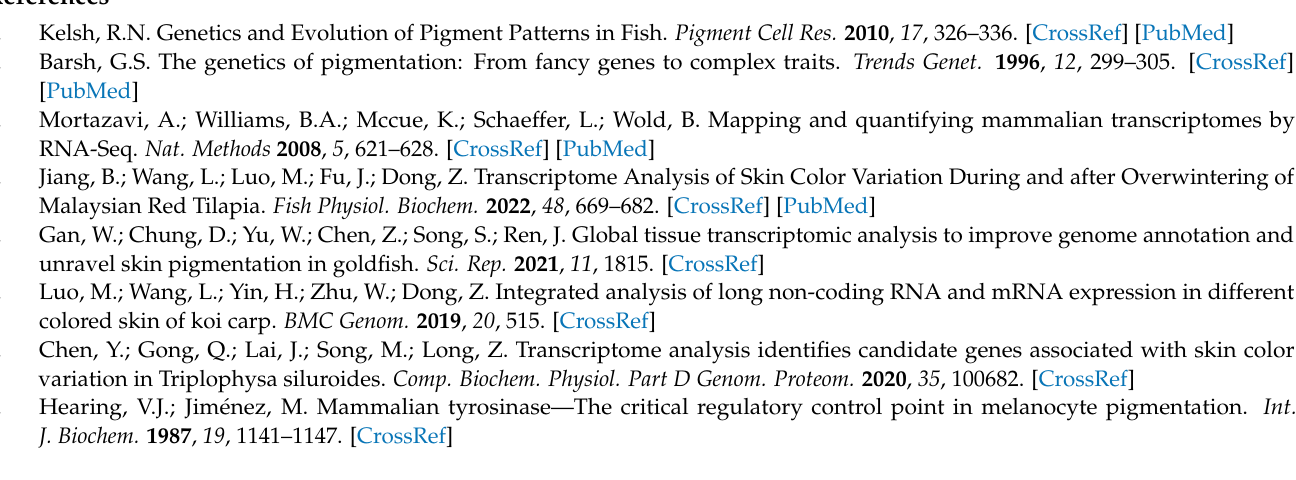
Table S2. Identified novel genes annotate by Pfam and GO function. Table S3. Differentially expressed mRNAs in skin tissues among three groups. Table S4. GO enrichment analysis for DE mRNAs in skin tissues among three groups. Table S5. KEGG enrichment analysis for DE mRNAs in skin tissues among three groups. Table S6. A total of 19 common differentially expressed genes among three groups. Table S7. Primers sequences for